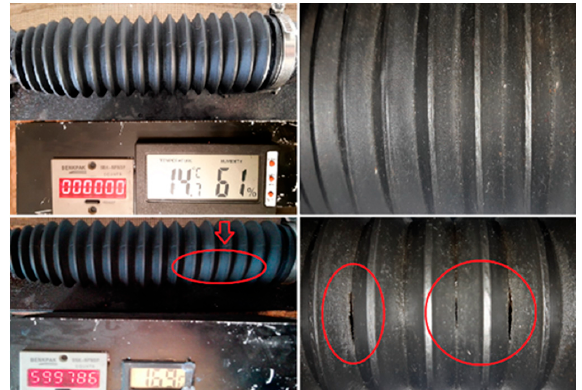
Figure 6. The presentation of the cuff’s state at the start and the end of the testing on sample no. 1, where the cuffs were on a vehicle exploited in the northern region.